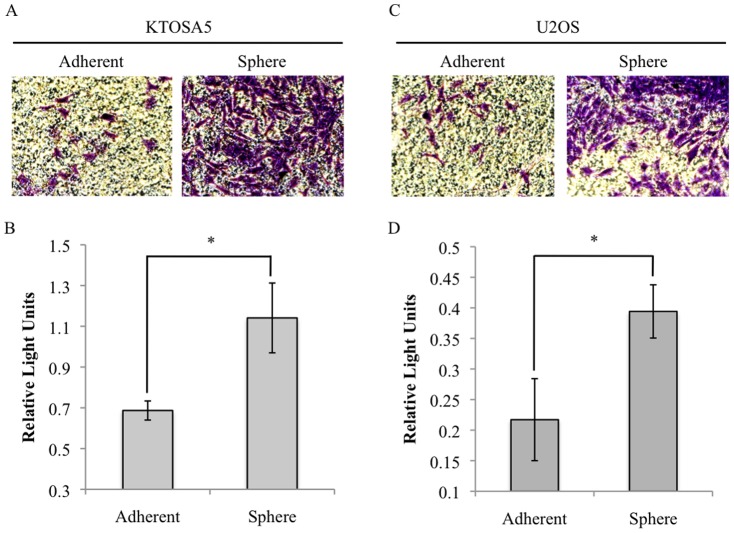
Cancer stem cells show an increased invasive potential in vitro.Invasive ability of KTOSA5 (A, B) and U2OS (C, D) spheres and adherent cells was analysed using a collagen based invasion assay. Invading cells were quantified by measuring the optical density at 560 nm. * p<0.005.